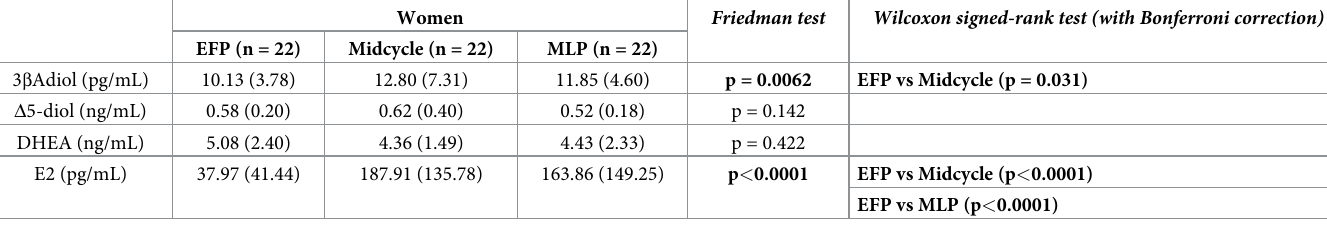
Table 1. Serum steroid levels at three time-points in the menstrual cycle. Women Friedman test Wilcoxon signed-rank test (with Bonferroni correction)